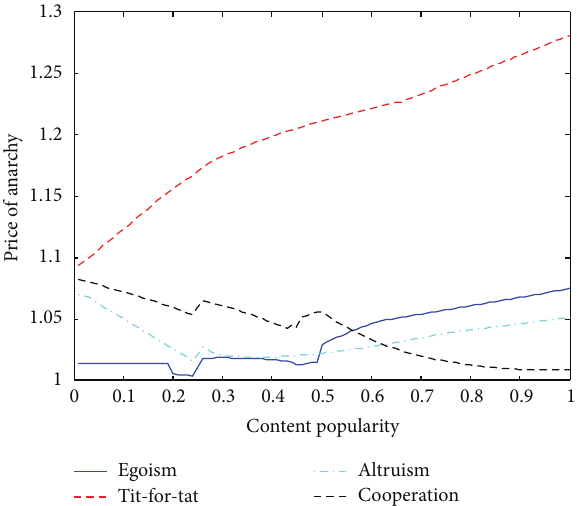
Figure 4: Price of anarchy versus content popularity.